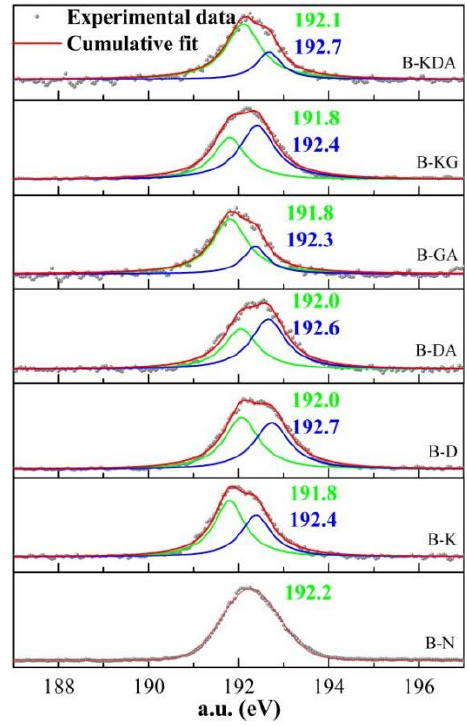
Figure 10. XPS for different samples.